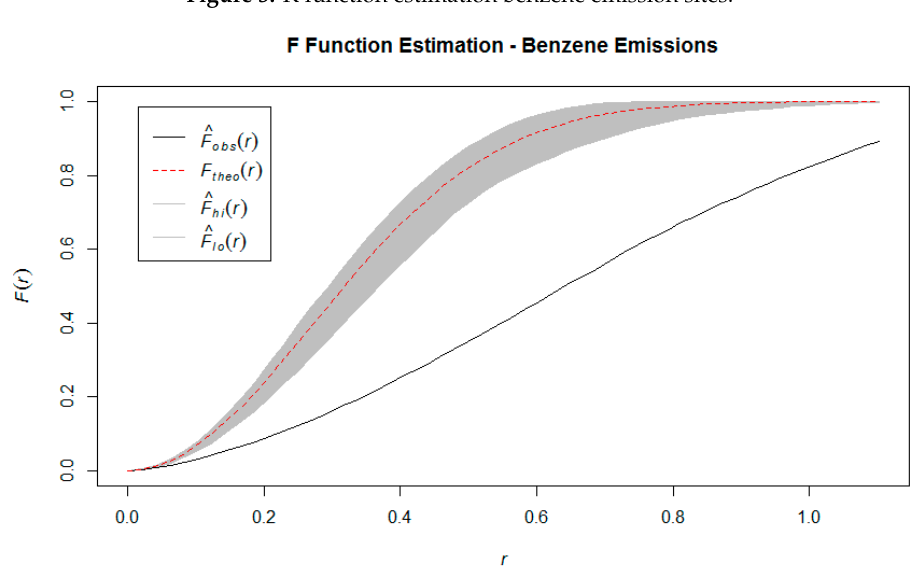
Figure 4. F function estimation benzene emission sites.